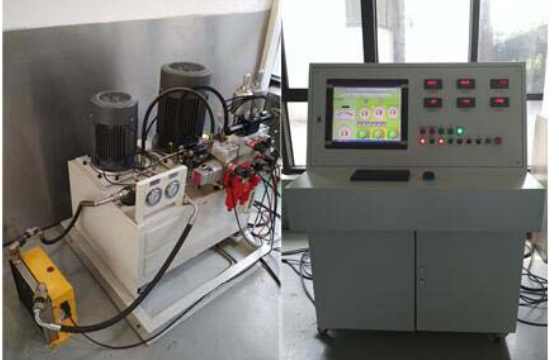
Figure 6. Micro digital valve test system.